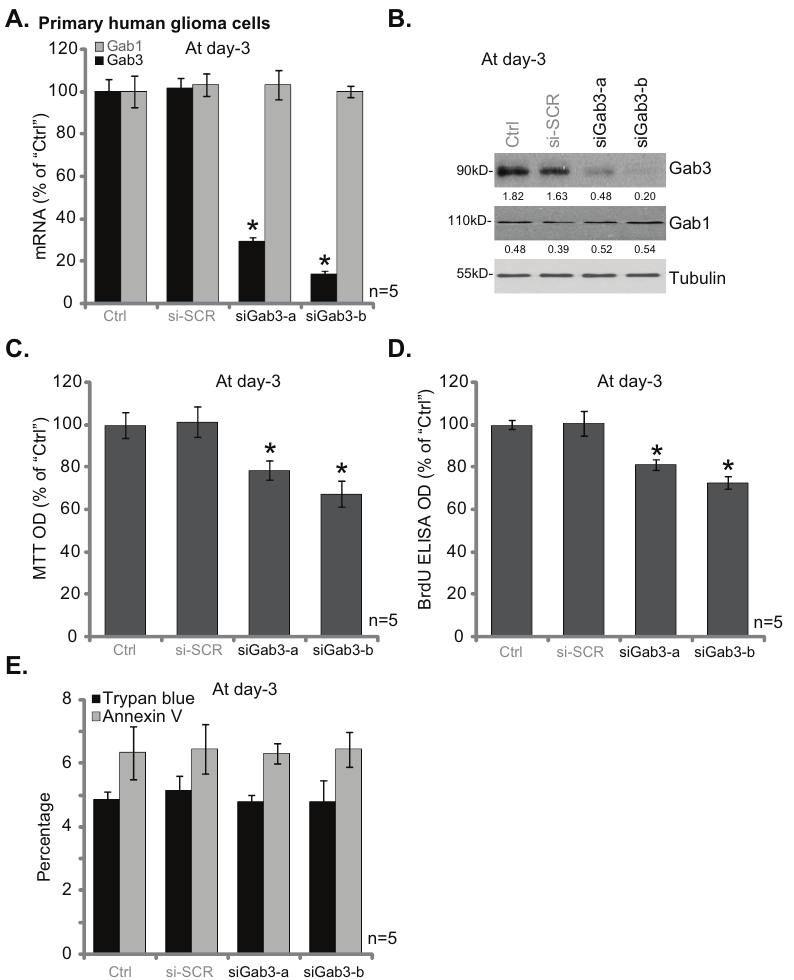
Fig 3. Gab3 siRNA inhibits primary human glioma cell proliferation. The primaryhumangliomacells, transfected with Gab3siRNAs(“siGab3-a/-b”) or scramblecontrolsiRNA(“si-SCR”),as wellas the non- transfected control(“Ctrl”) cells, weresubjectedto qRT-PCR assay(A) andWesternblottingassay (B) to tested listedgenes;Cellproliferationwas tested by MTT assay(C) andBrdU ELISA assay(D); Celldeath(trypanblue stainingassay)andapoptosis(AnnexinV stainingassay)werealsotested (E). Relativeexpression of listed proteinswas quantified ( vs .Tubulin,B). For all theseassays, the exact samenumberof cellsof different treatment wereinitiallyplatedinto eachwell/dish. Data werepresented as mean ± SD. * p < 0.05 vs .“Ctrl” cells.